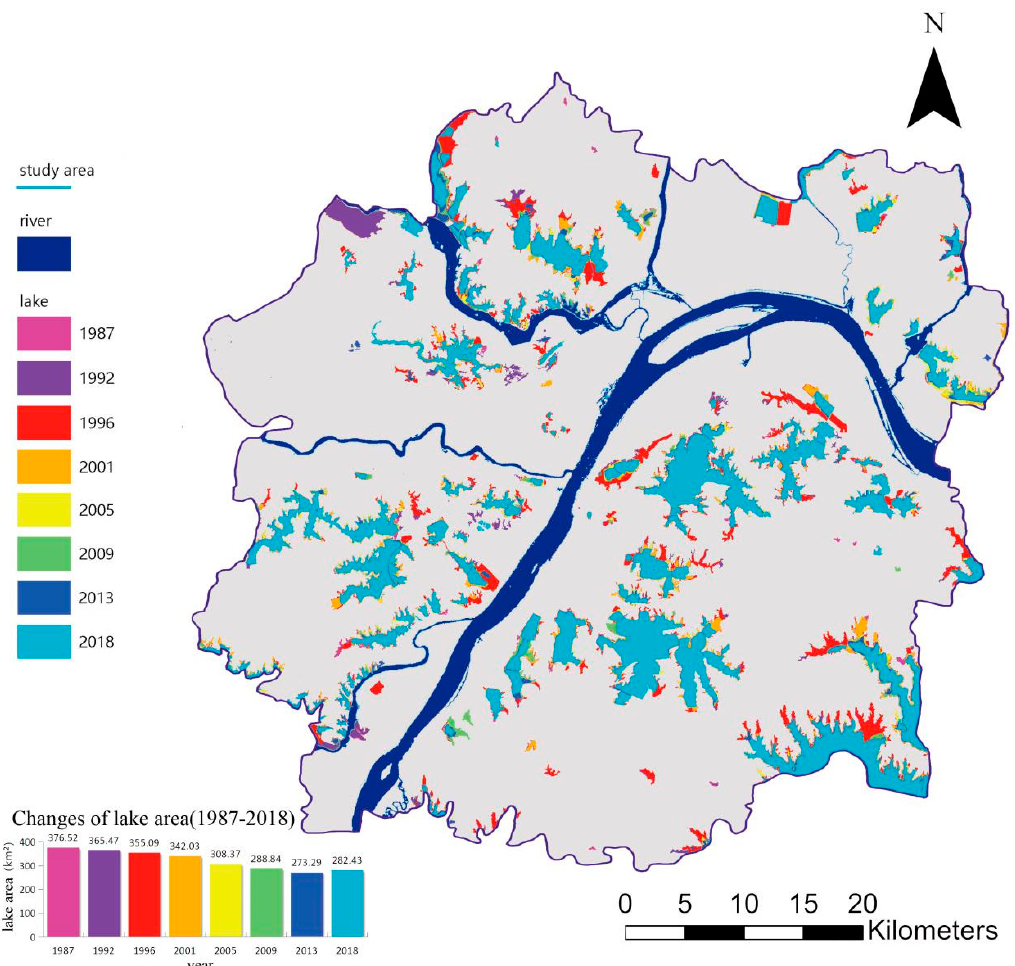
Figure 4. Lake evolution map of Wuhan urban development area in 1987 – 2018.